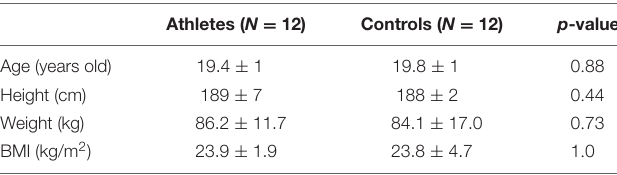
TABLE 1 | Information of young basketball athletes and the